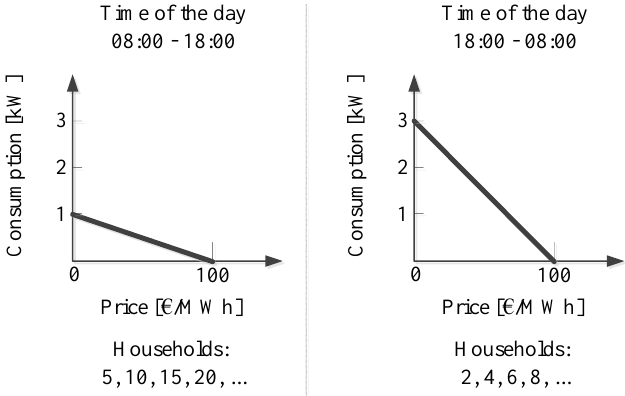
Figure 3. Response of the flexible loads on the electricity price for different moments of the